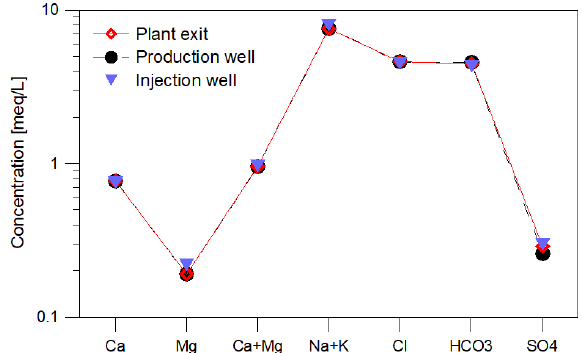
Figure 5. Mineralization of the geothermal fluid at the plant in Unterhaching as Schoeller diagram (average 2017–2019). Samples were procured at all sampling sites (red: plant exit, black: produc- tion well, blue: injection well) and were found to be nearly identical. The composition was observed throughout the monitoring period.